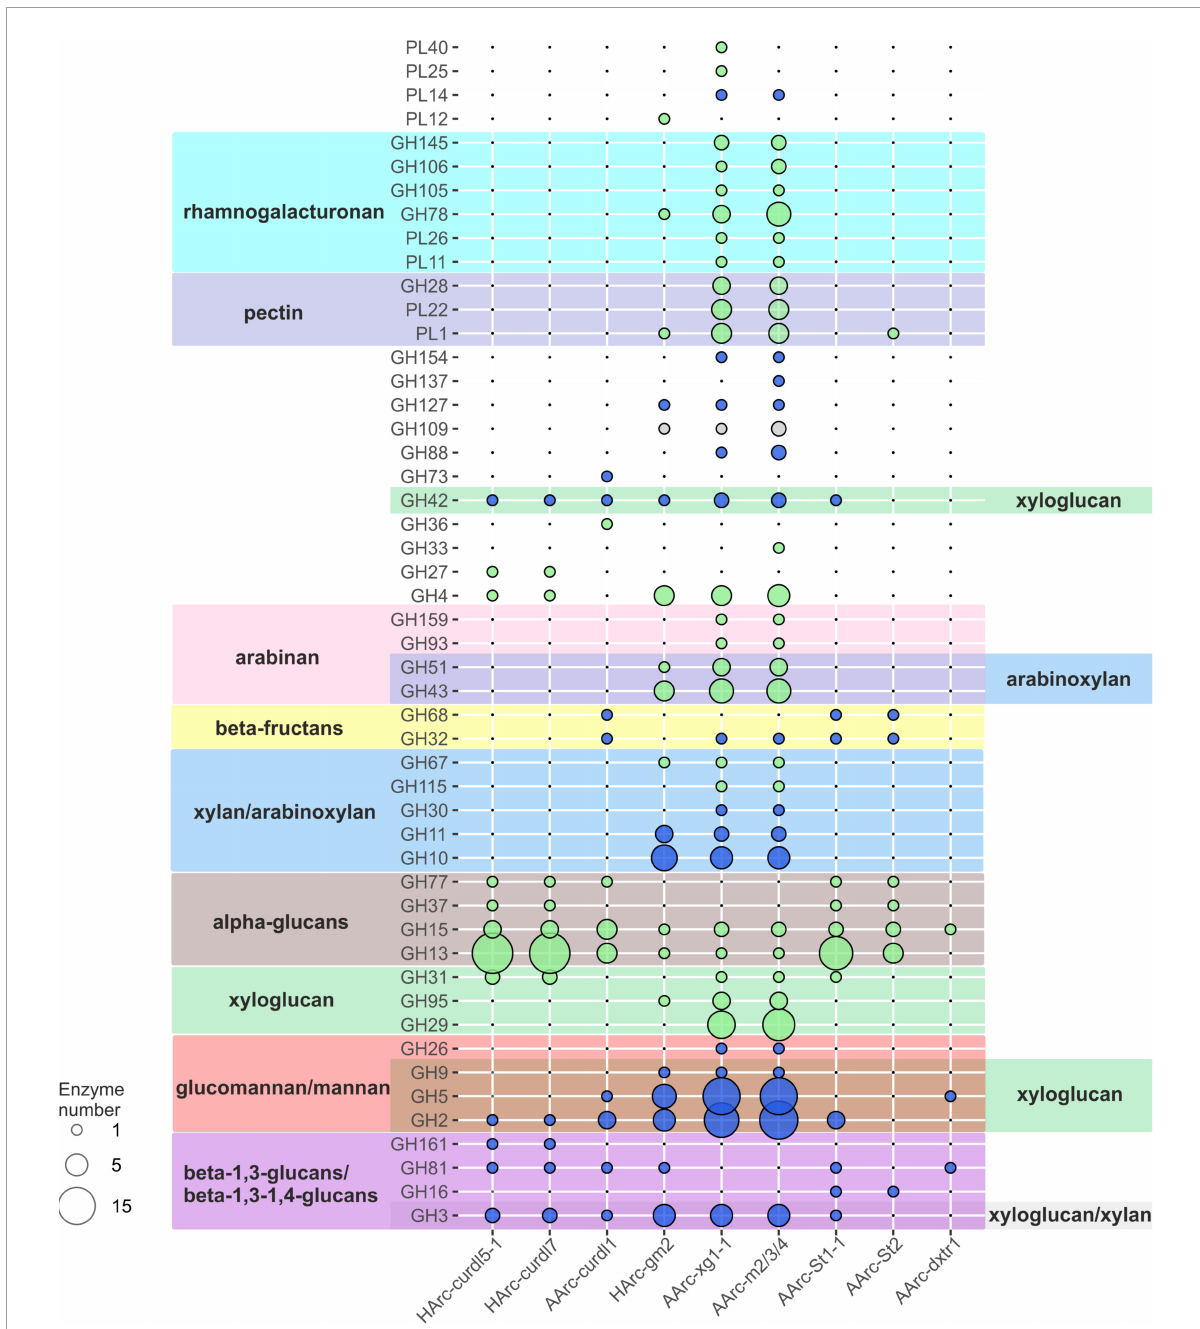
FIGURE4 Sets of GH and PL genes found in the genomes of novel polysaccharidolytic haloarchaea. Size of bubbles indicate number of enzymes; the color of bubbles indicate the prevailing type of glycosidic bonds hydrolyzed by the enzymes (alpha-bonds—green, beta-bonds—blue, both—gray). Color of background indicates these CAZymes families contains the characterized enzyme(s) capable of depolymerization of respective polysaccharides. No color means the activities, characteristic to these families are not directly linked to the substrates used in this work.